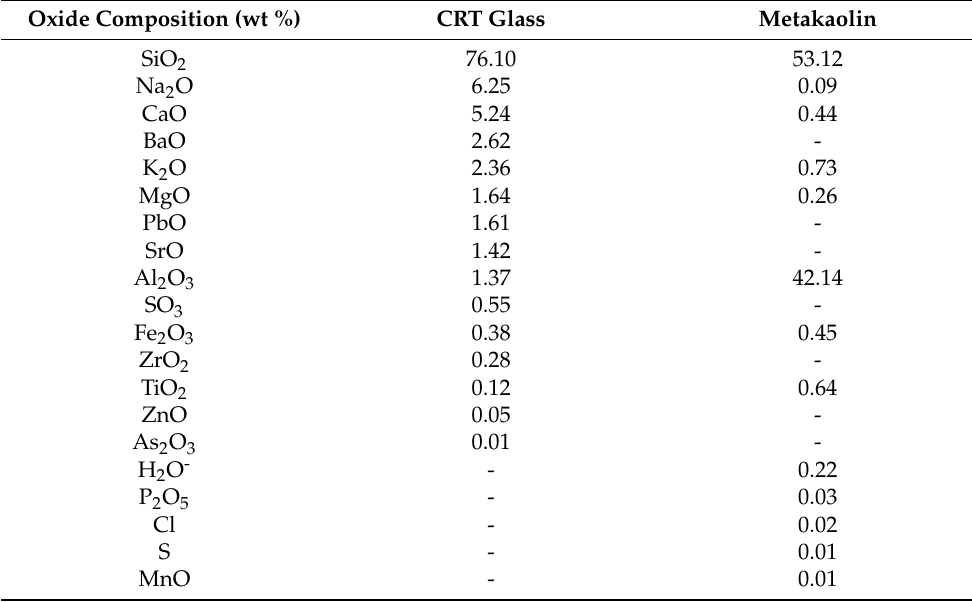
Table 1. Chemical compositions of metakaolin 1 and cathode ray tube (CRT) glass 2 . Oxide Composition (wt %) CRT